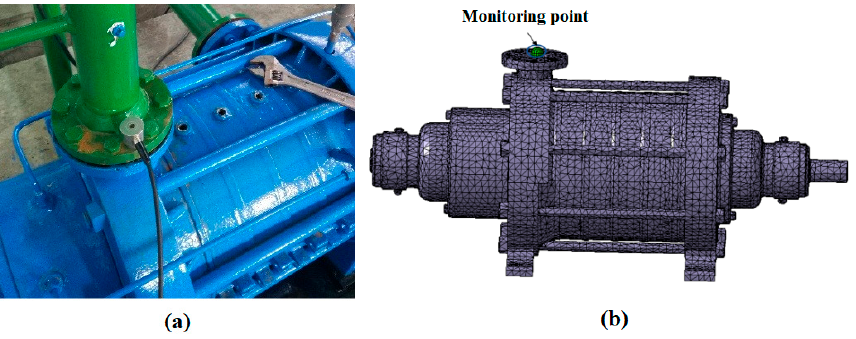
Figure 8. The ( a ) experiment and ( b ) simulation models of vibration.